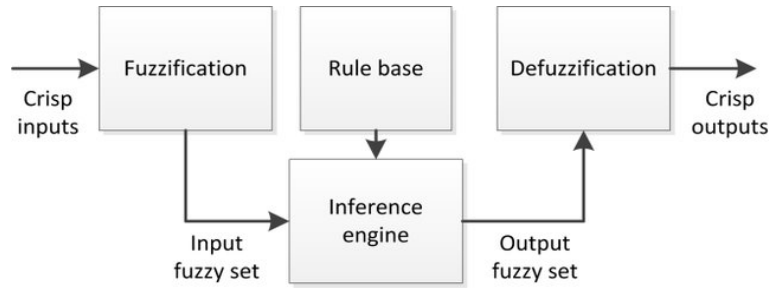
Figure 7. The measured and simulated model output.